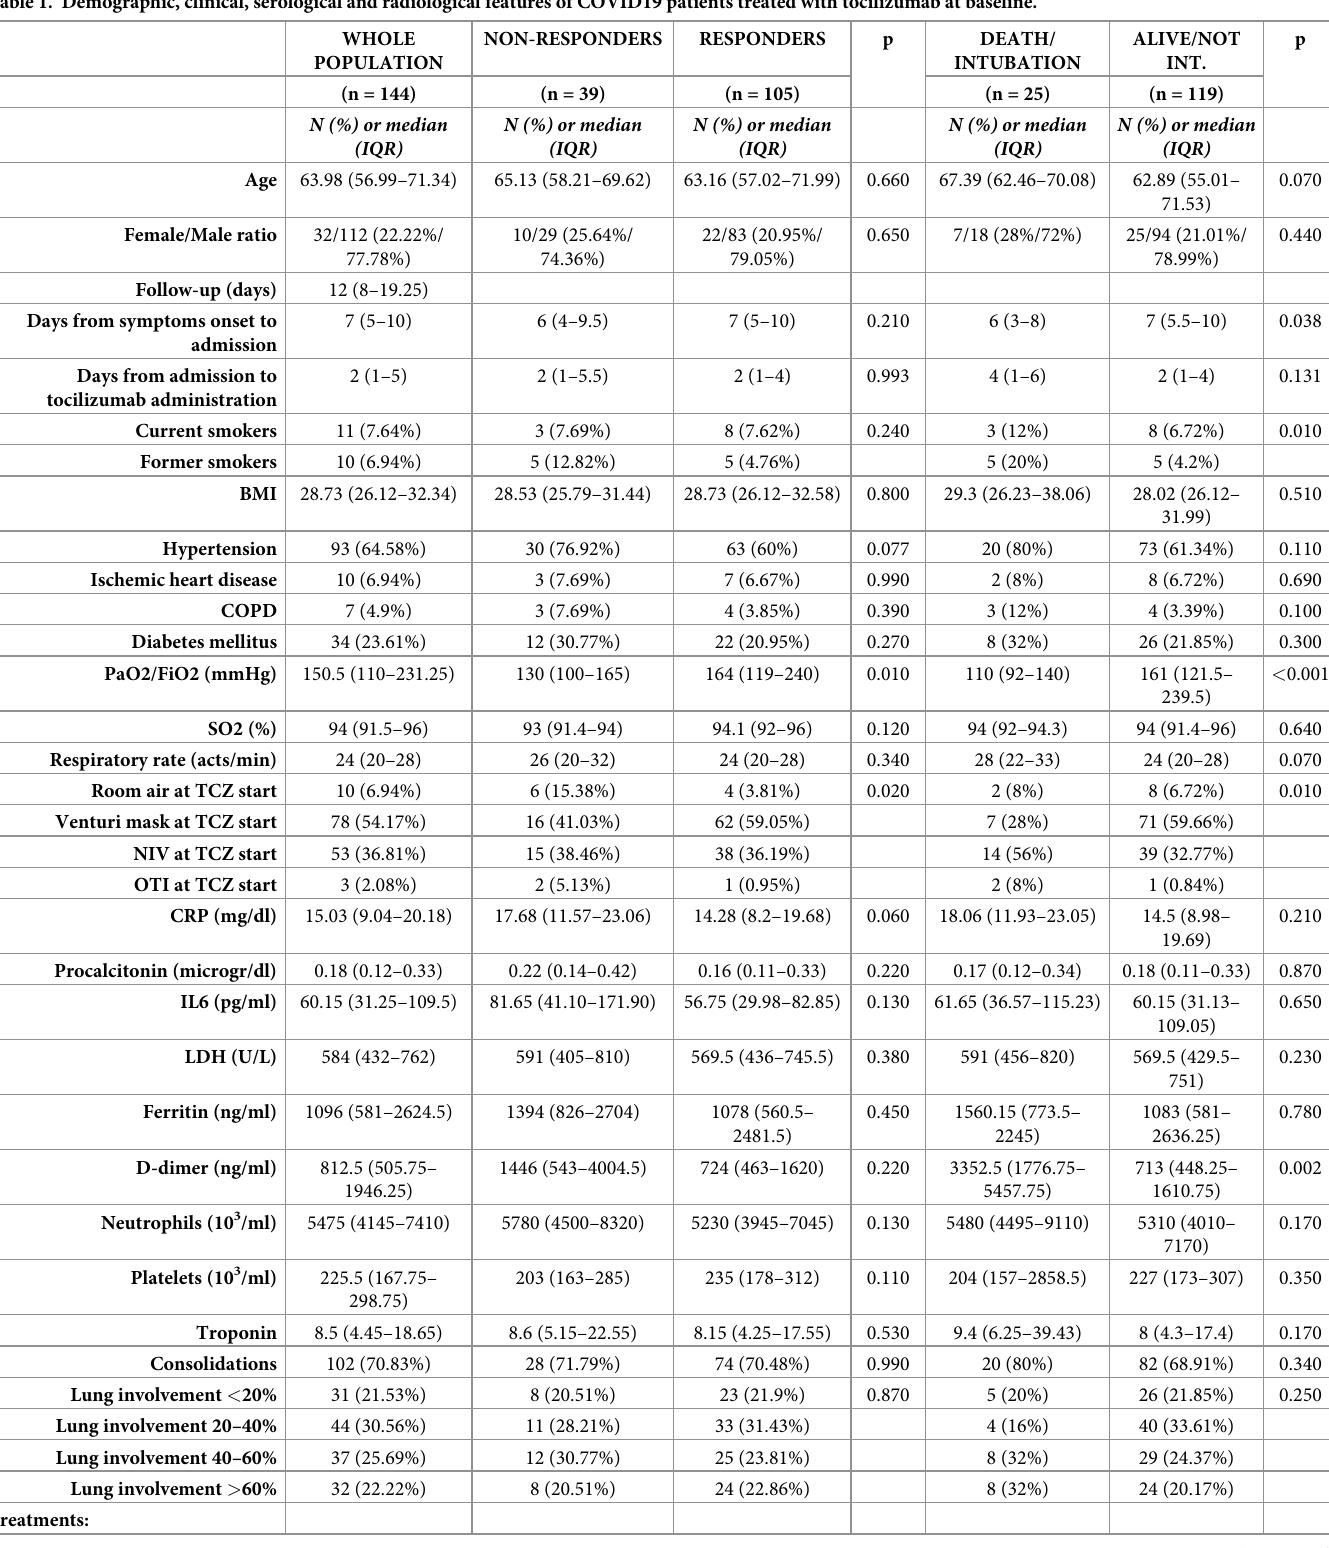
Table 1. Demographic, clinical, serological and radiological features of COVID19 patients treated with tocilizumab at baseline. WHOLE POPULATION